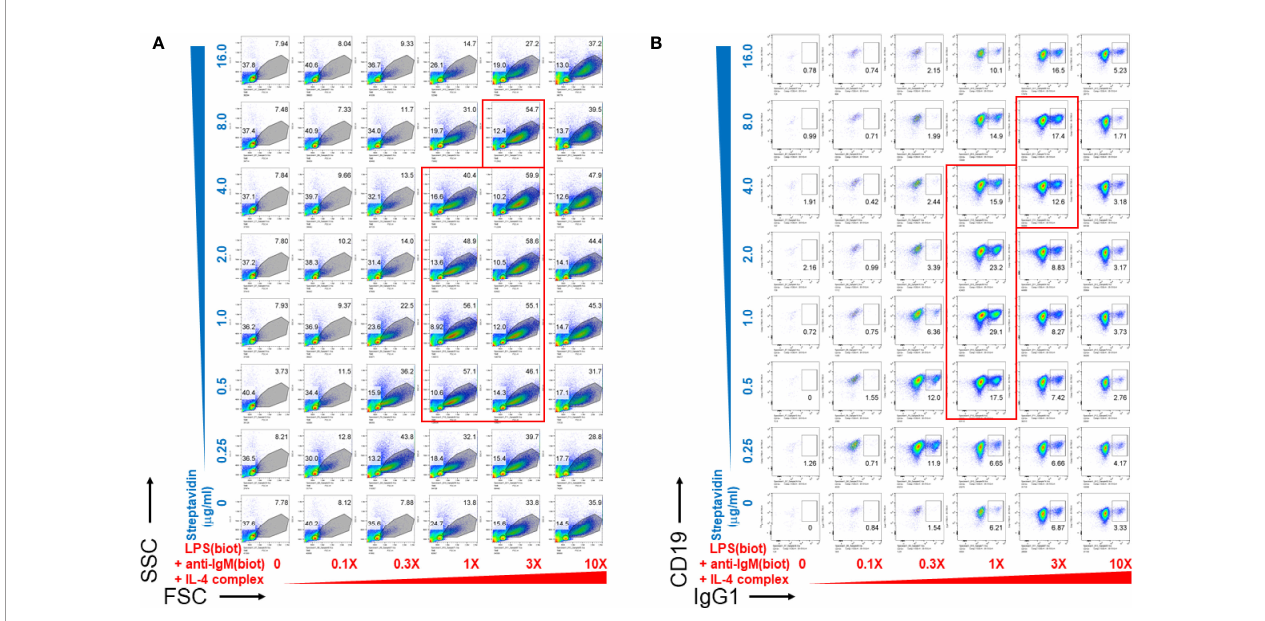
FIGURE 2 | Pre-assembly of immunoconjugates is critical for their narrow dose-dependent B cell proliferation that correlates with class switching. Biotinylated LPS (S. abortus equi), biotinylated anti-IgM F(ab ’ ) 2 , and anti-IL-4 mAb complexed with IL-4 were titrated along the columns (x-axis) of a 96 well V-bottom plate, whereas streptavidin was titrated along its rows (y-axis) in the indicated concentrations. Since LPS, anti-IgM and IL-4 were used at different concentrations for each well, the 1X (1-fold) concentration was: 1 m g/ml biotin-LPS, 0.2 m g/ml biotin-anti-IgM F(ab ’ ) 2 , 10 ng/ml IL-4 complexed to 100 ng/ml biotin-anti-IL-4. The X-fold titration refers to multiples of this 1X cocktail of B cell stimulating stimuli. After pre-assembly of the biotinylated stimuli with streptavidin for 2 hrs, then were then added to the corresponding wells of a 96 well fl at bottom plate containing splenocytes (2.5 x 10 5 cells/ml in each well) in RPMI-FBS medium supplemented with BME. Cells were harvested after 4 days and stained with a cocktail of antibodies, including CD19 and IgG1. (A) Proliferation was visible as the increase in cell size in the forward scatter (FSC) channel, peaking at only certain ratios of biotinylated stimuli vs streptavidin (the most robust wells are included in the red rectangles). (B) CSR to IgG1 also peaked at only certain ratios of biotinylated stimuli vs streptavidin, which generally correlates with the extent of proliferation as in (A) (wells with the highest CSR are included in the red